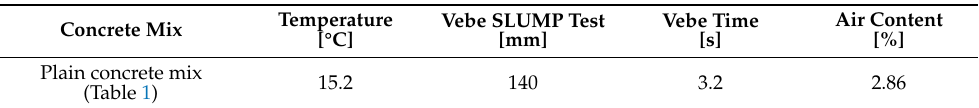
Table 2. Properties of new concrete